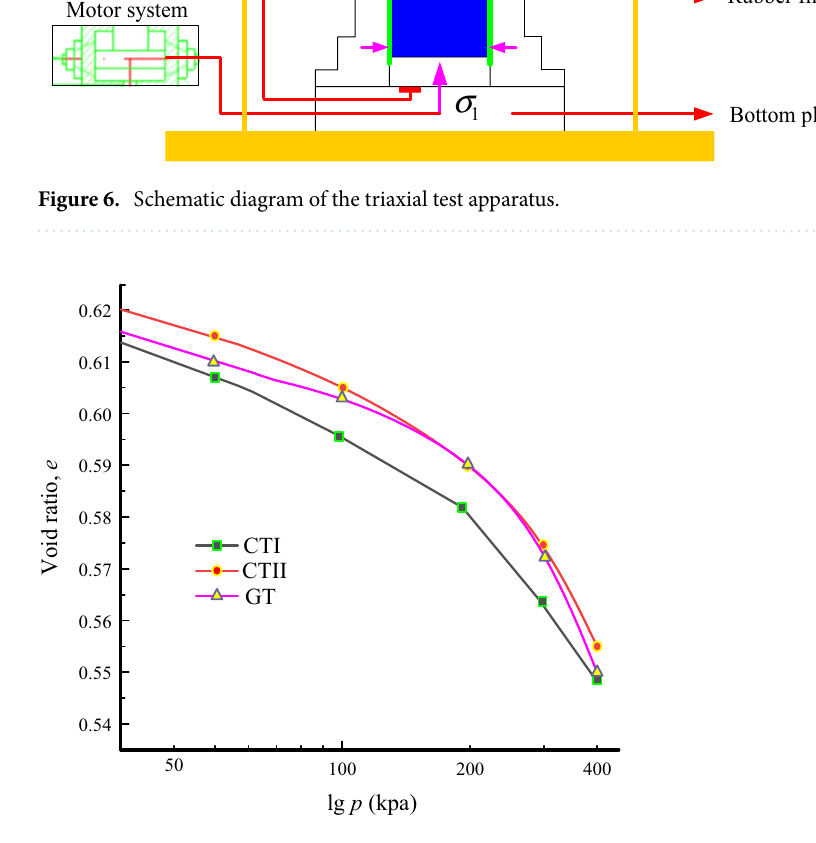
Figure 7. Compression curves of tailings samples with different mineral compositions.